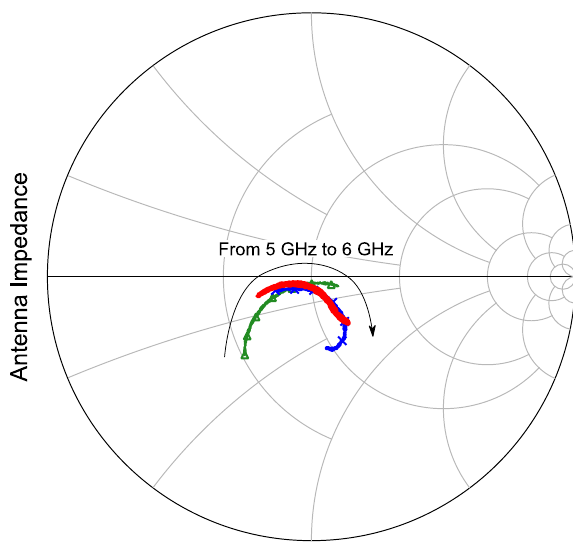
Figure 9. Antenna impedance measurements for three different scenarios: standalone antenna (red solid line) integrated in a worktop (green reverse triangle line) and mounted underneath the worktop (blue thick line). Frequency goes from 5 to 6 GHz according to the direction of the arrow.